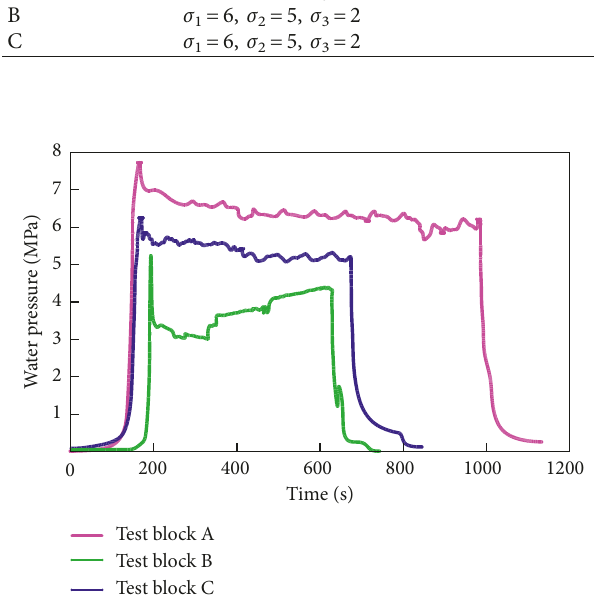
Figure 4: Water pressure during hydraulic